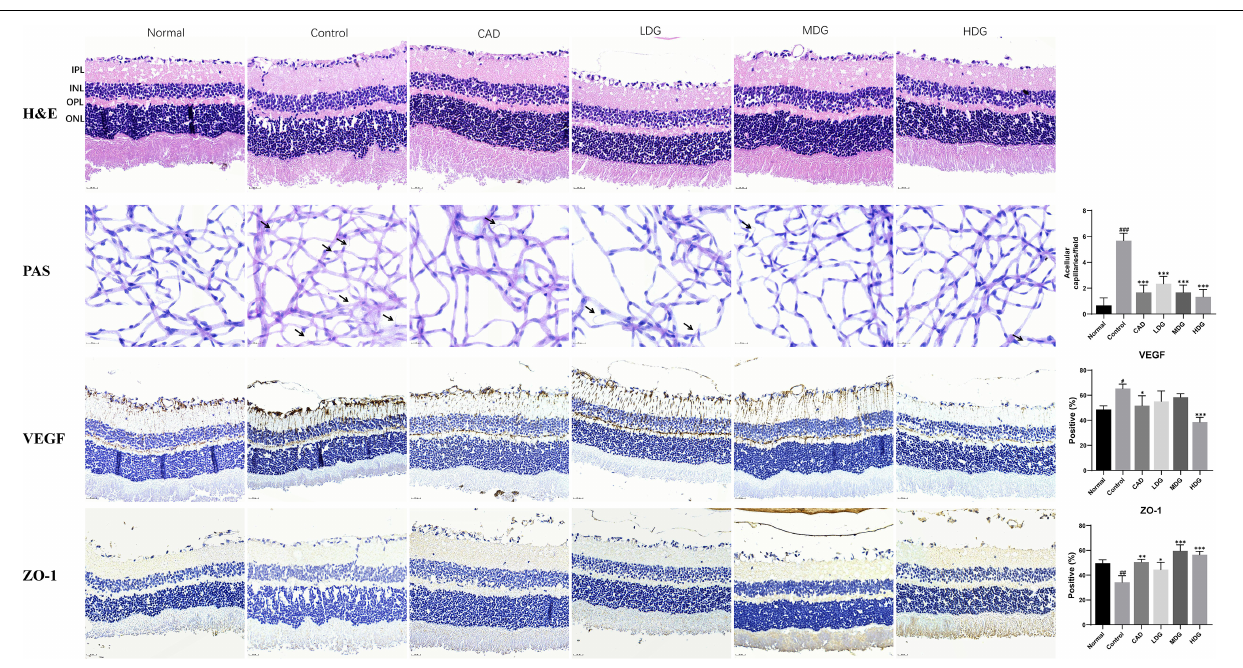
Frontiers in Cardiovascular Medicine |